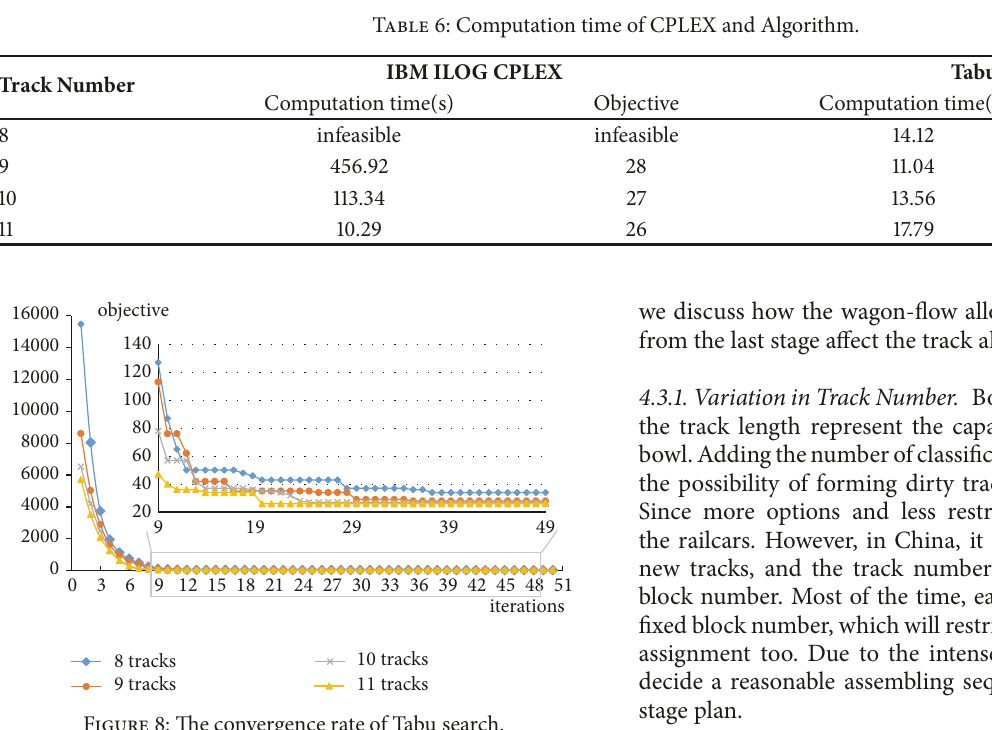
Figure 8: The convergence rate of Tabu